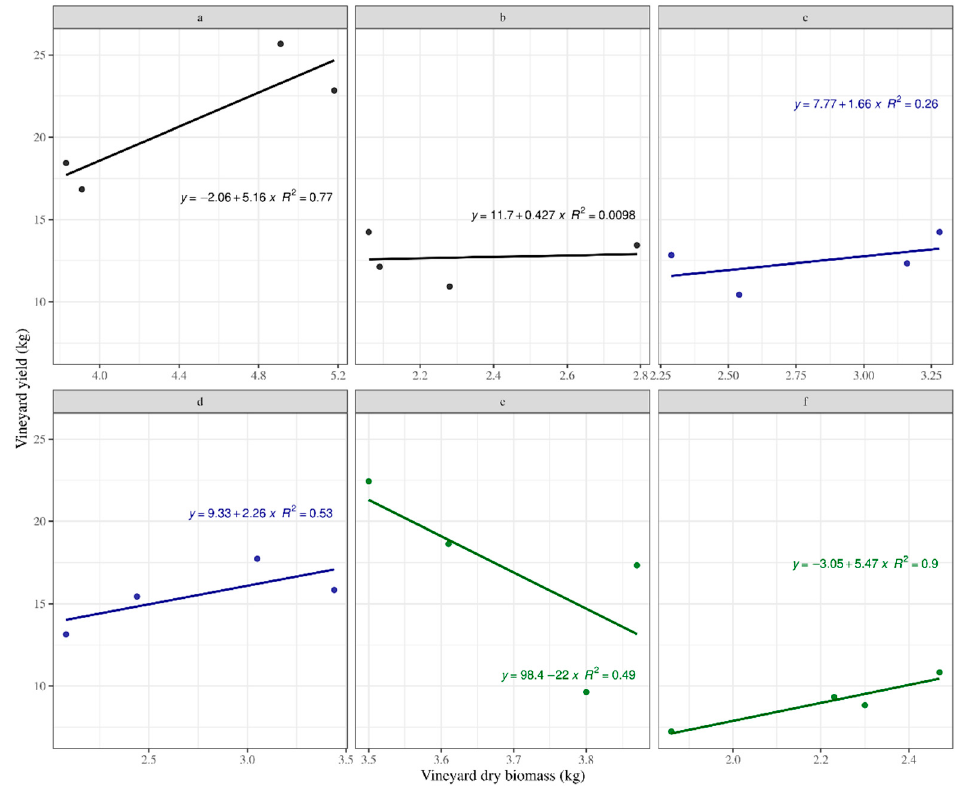
Figure 5. Behaviour of the measured (truth) vineyard dry biomass versus the measured (truth) vineyard yield, according to the different agronomic treatments (averaged per treatment). Table 1. Regression slope coe ffi cients, standard error, P-value of the F-tests and corresponding 95% confidence intervals (95% CI) of the estimated slopes, indicating the meaningful correlations between Kinect v2 calculated volume and the measured response variables vineyard yield and dry